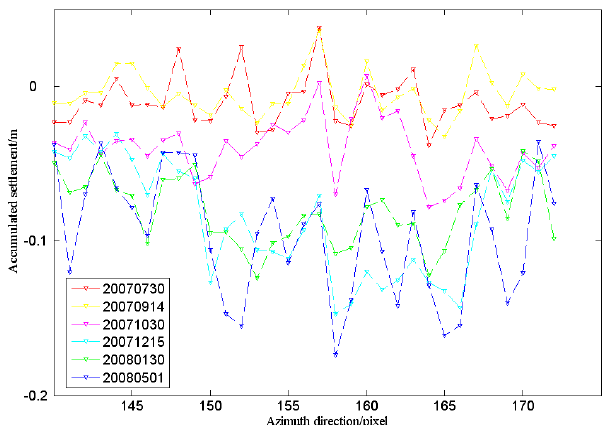
Figure 6.Time series settlement profile of subsidence funnel A in bearing direction